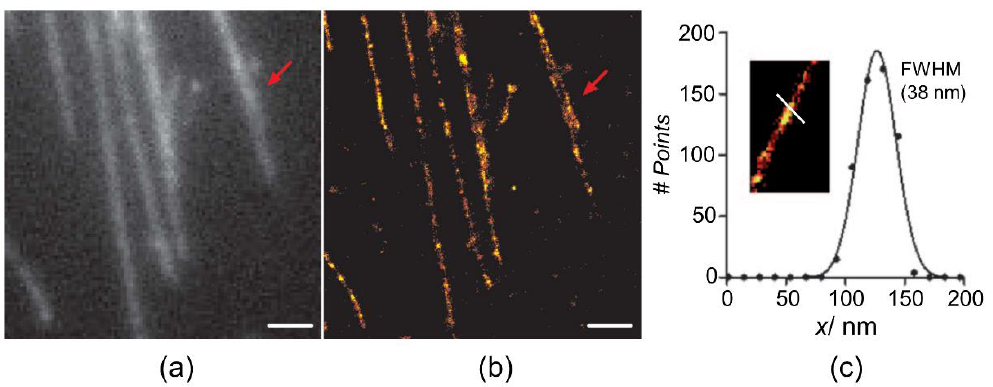
Figure 3. ( a ) Wide-field image of λ-DNA labeled with YOYO-1 dye, observed via SR imaging with an integration time of 100 ms and ( b ) reconstructed image with the density of localization. ( c ) The resolution across the DNA is 40 nm with Gaussian fitting of the line. The region indicated by red arrows shows the difference in the observation between the wide-field and SR images of dsDNA (scale bar: 1 µm). Reproduced with permission from Flors et al., published by Wiley-VCH Verlag Gmbh, 2018 [26].